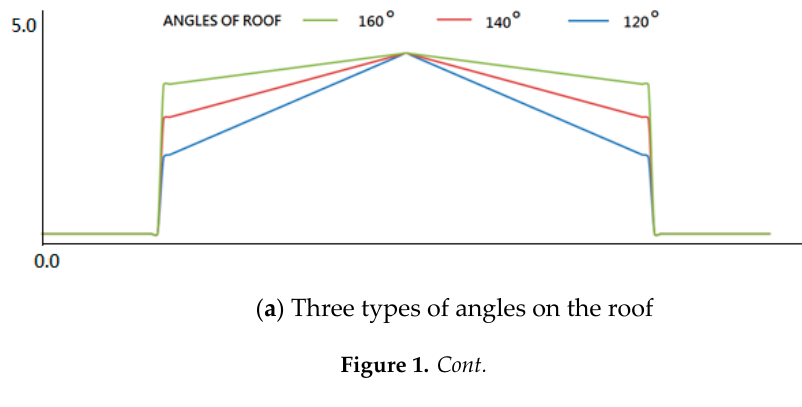
( a ) Three types of angles on the roof Figure 1.